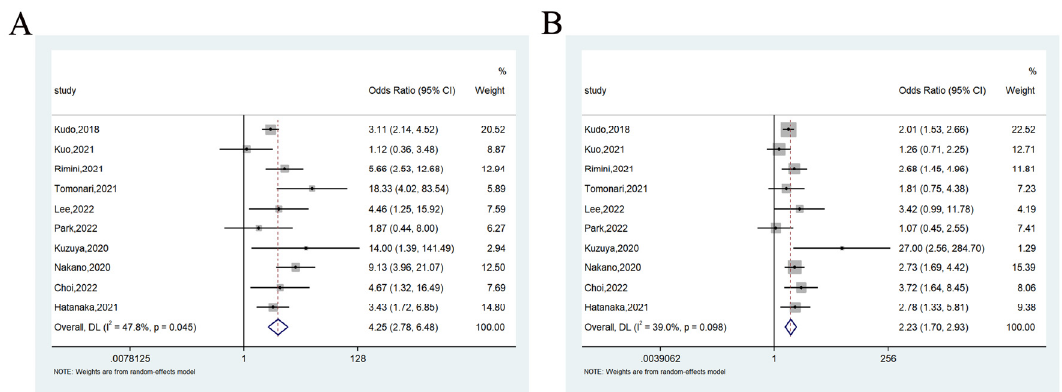
Figure 6. Forest plots of the ORR ( A ) and DCR ( B ) associated with lenvatinib vs. sorafenib.